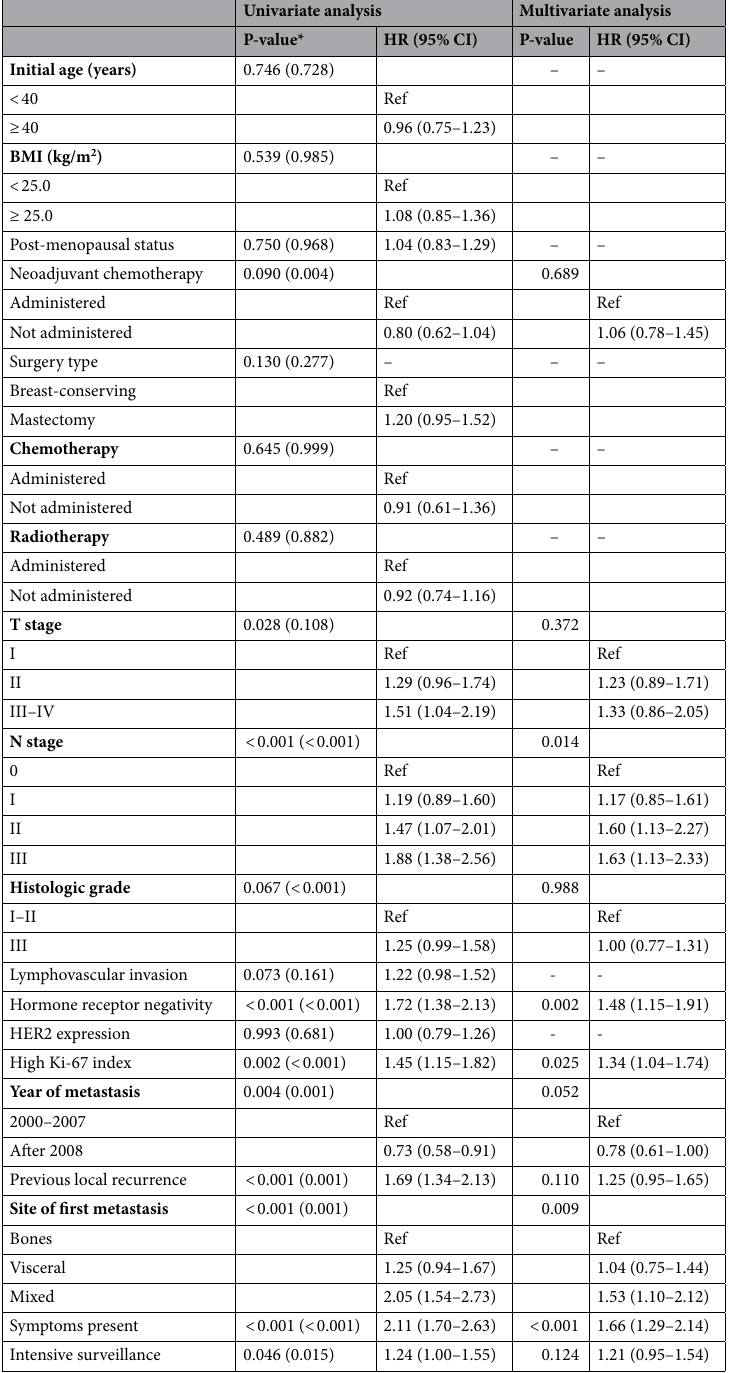
Table 2. Clinicopathologic features affecting post-operative overall survival. HR hazard ratio, CI confidence interval, BMI body mass index, HER2 human epidermal growth factor receptor 2, Ref. reference. *The p values are derived from the Log-rank test and the p values from the Breslow test are shown in the